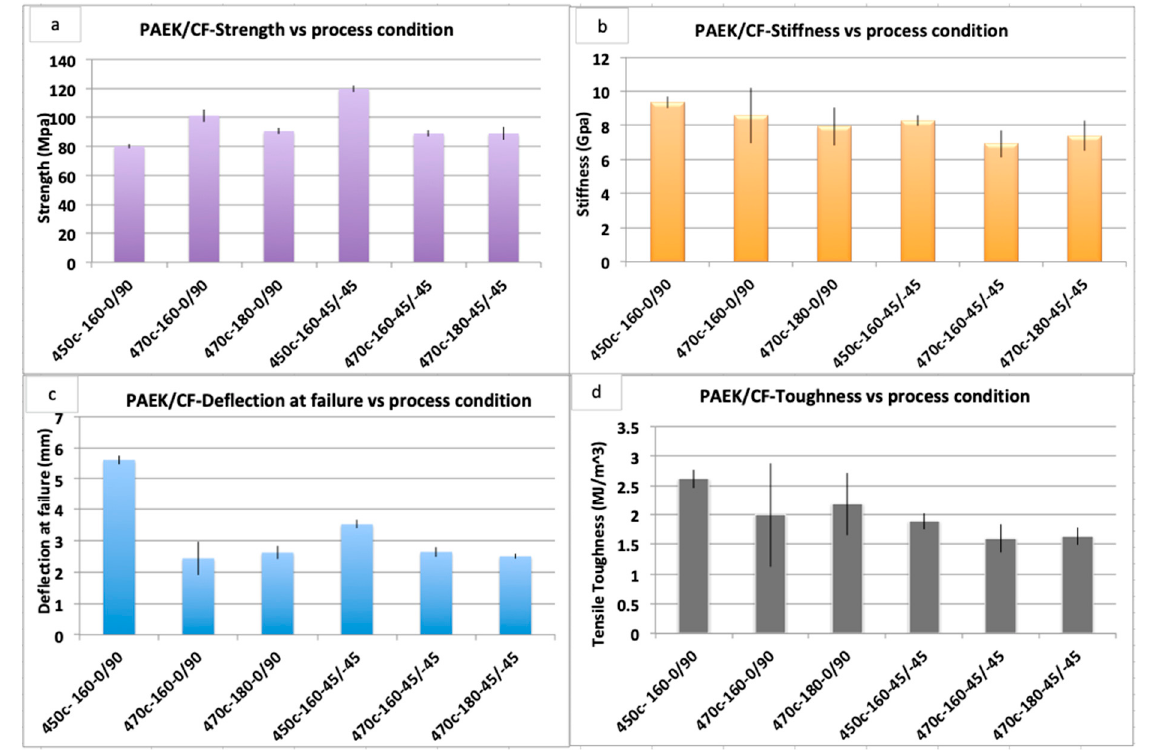
Figure 10. PAEK/CF samples made at 470 °C show a drop in mechanical properties, ( a ) strength, ( b ) sti ff ness, ( c ) de fl ection at failure, and ( d ) toughness, compared to samples made at 450 °C. The X-axis label shows the performance of PAEK or PAEK/CF at di ff erent nozzle temeparatures (430 °C and 450 °C) and oven temperatures (160 °C & 180 °C), for di ff erent raster angles (45/ − 45 & 0/90).